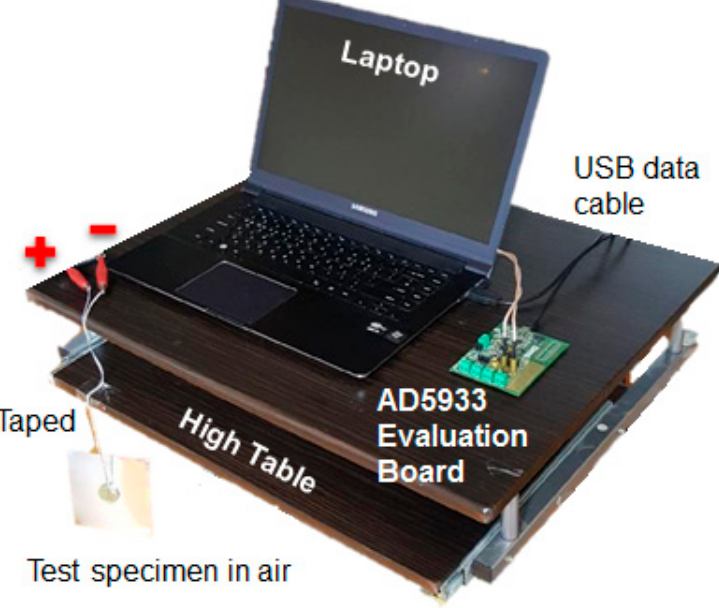
Figure 1. Electromechanical impedance experiment configuration.